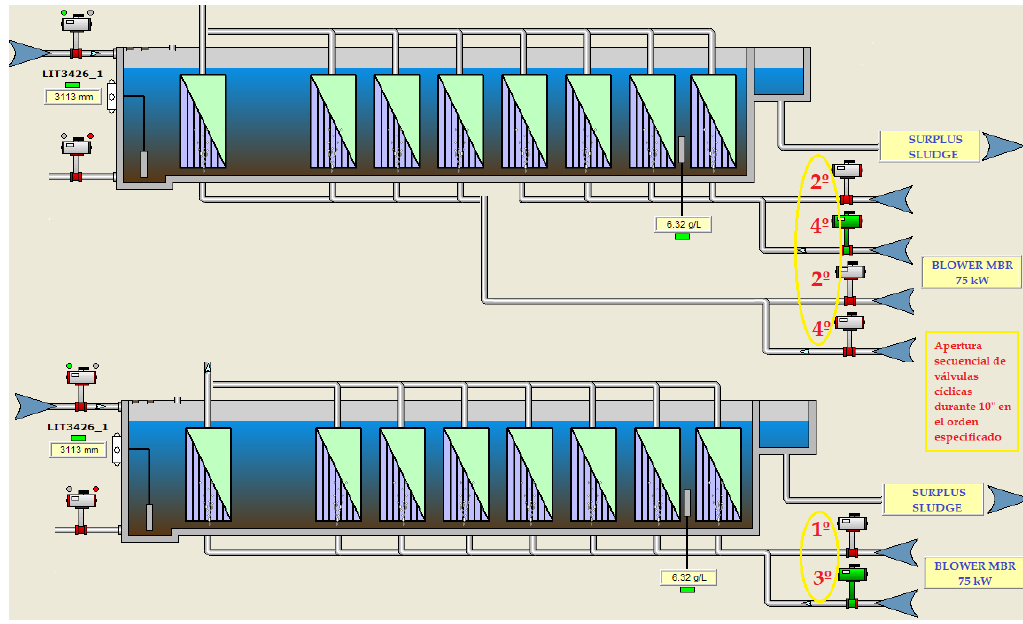
Figure 9. Actuation sequence of the aeration control valves in two-train mode.